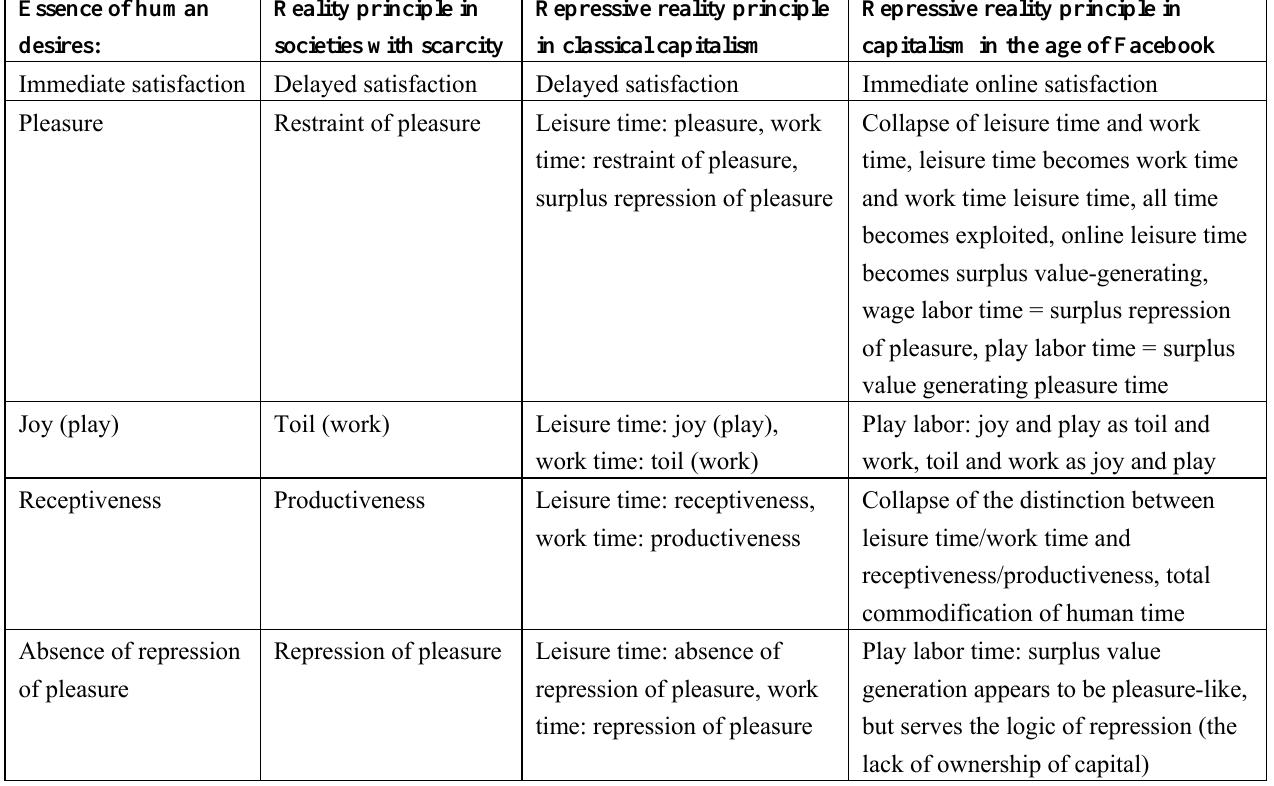
Table 1. Pleasures in four modes of society (human essence, society with scarcity, classical capitalism, capitalism in the age of Facebook), based on a table from: Marcuse 1955 [74], p.